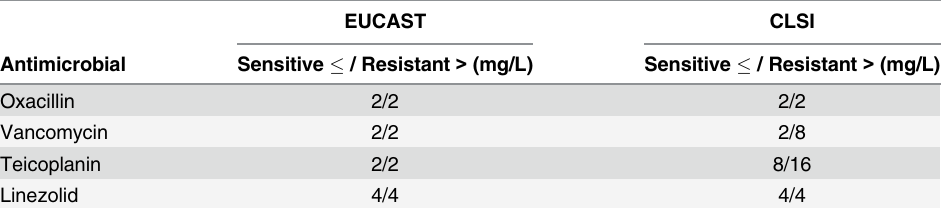
Table 1. MIC breakpoints for S . aureus according to EUCAST and CLSI guidelines.